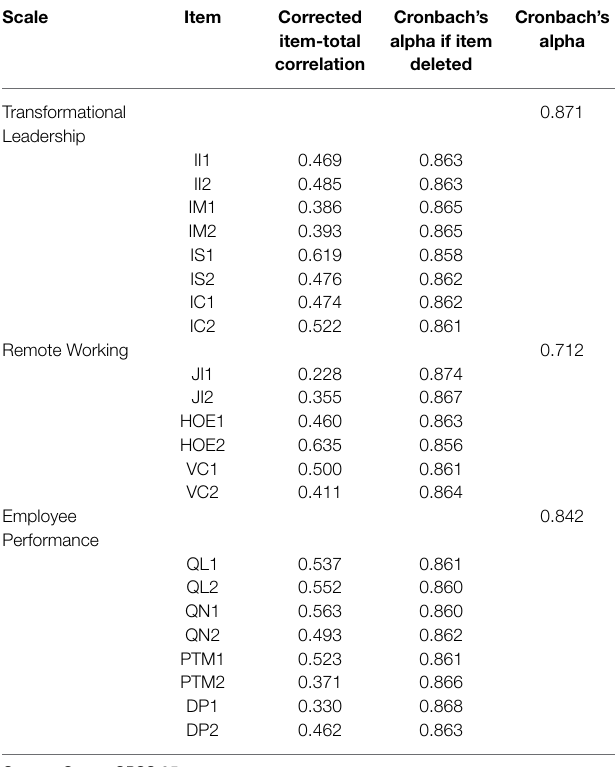
TABLE 3 | Validity and reliability